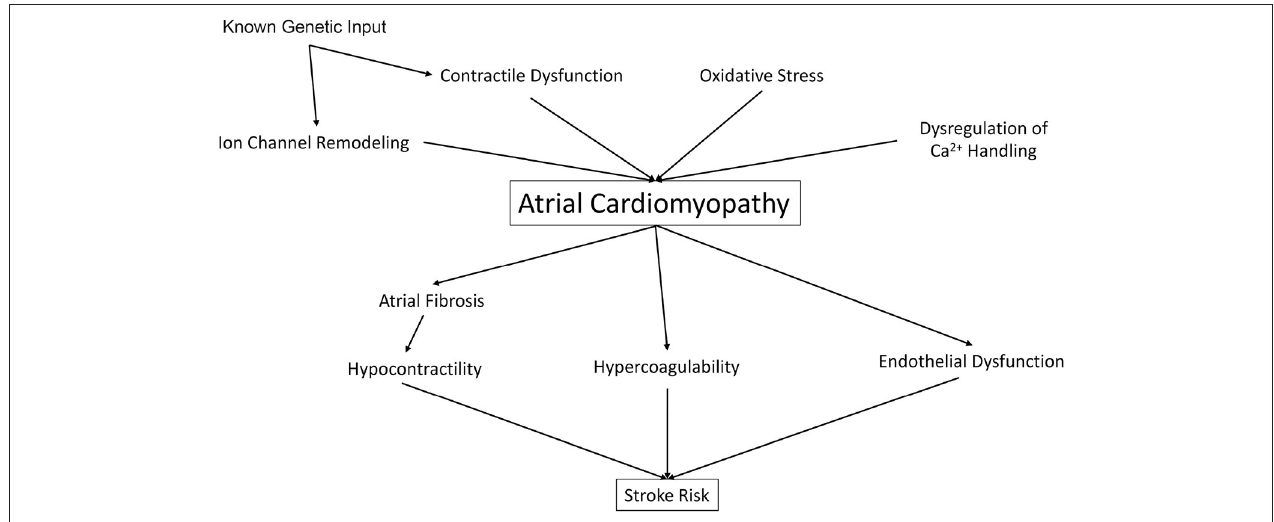
FIGURE 1 | Atrial cardiomyopathy risk factors increase risk for stroke.